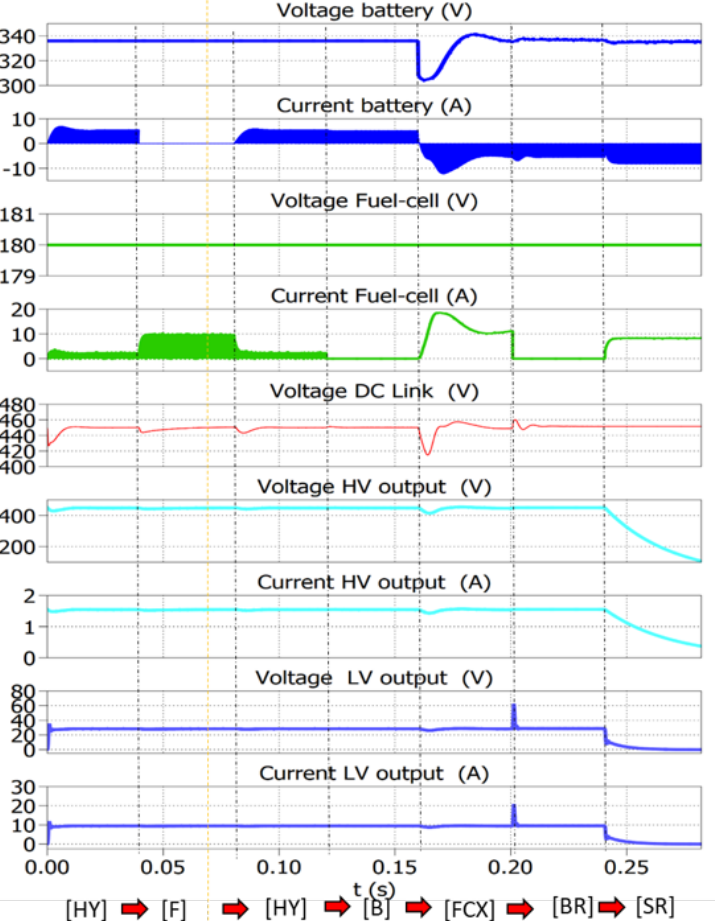
Figure 25. Experimental result of fuel cell voltage and current, battery voltage and current, DC–link voltage, HV load voltage and current, and LV load voltage and current during mode transitions of HY (hybrid) −→ F (Fuel cell to loads) −→ HY (hybrid) −→ B (Battery to load) −→ FCX (Fuel cell to load and battery charging) −→ BR (Battery recuperation) −→ SR (static